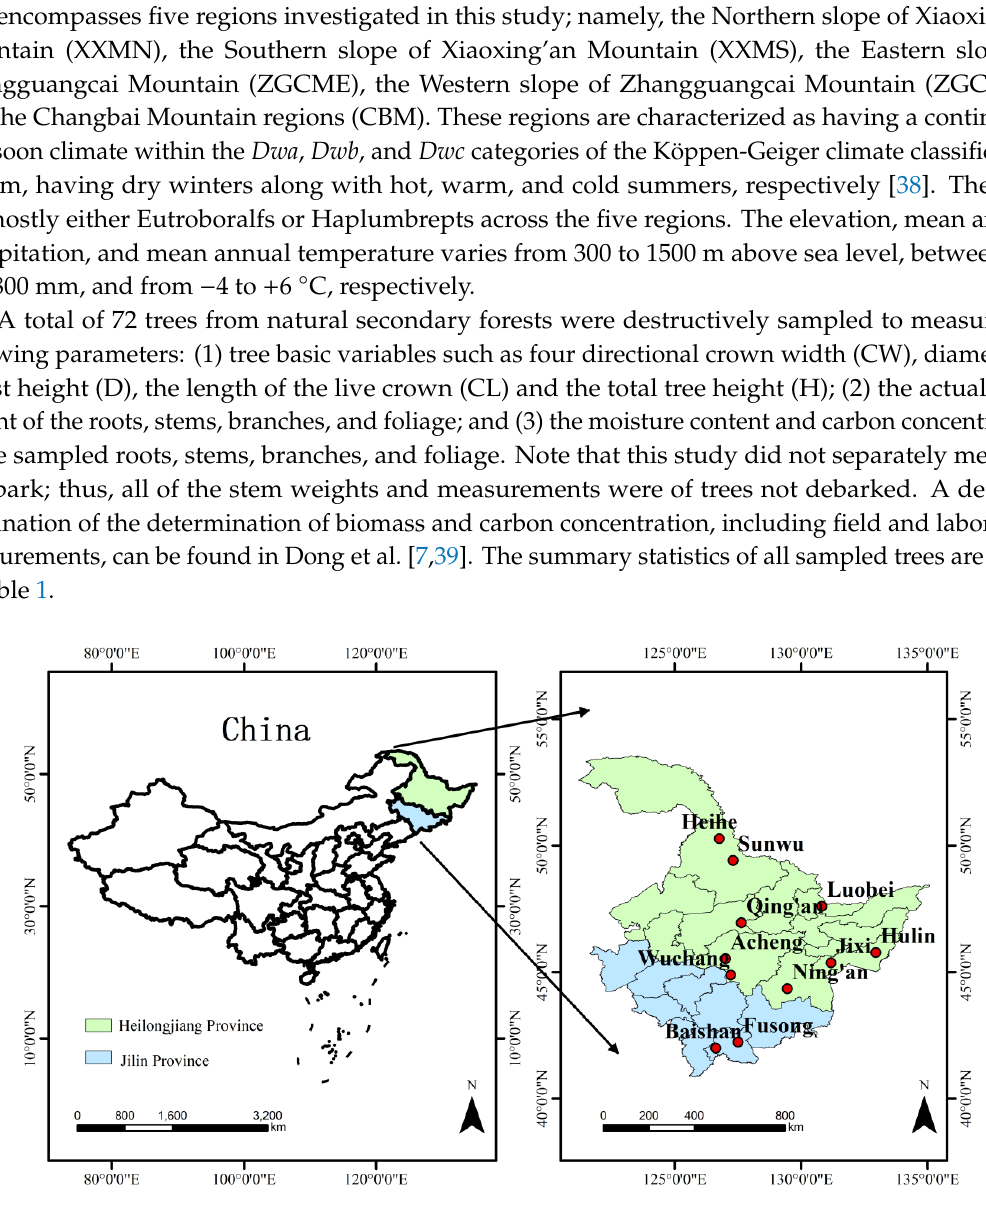
Figure 1. The location of the study area and the distribution of sample plots in Northeast